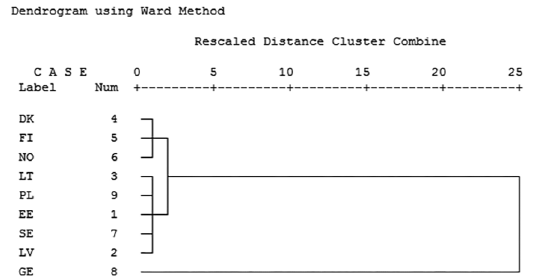
Fig. 5. Dendrogram representing the formation of countries’ clusters based on their railway transport flows during 2010–2011